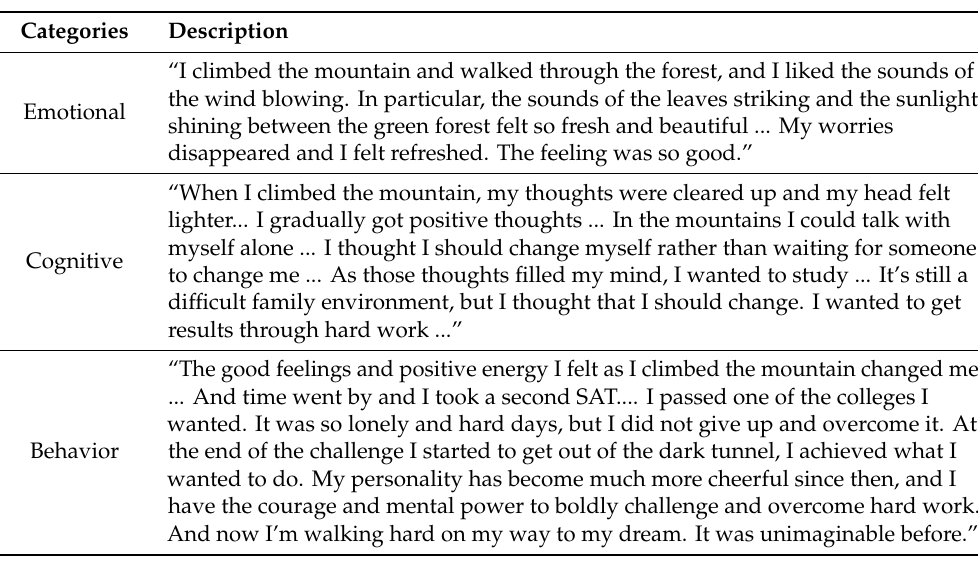
Table 3. Example case of emotional, cognitive, and behavioral change